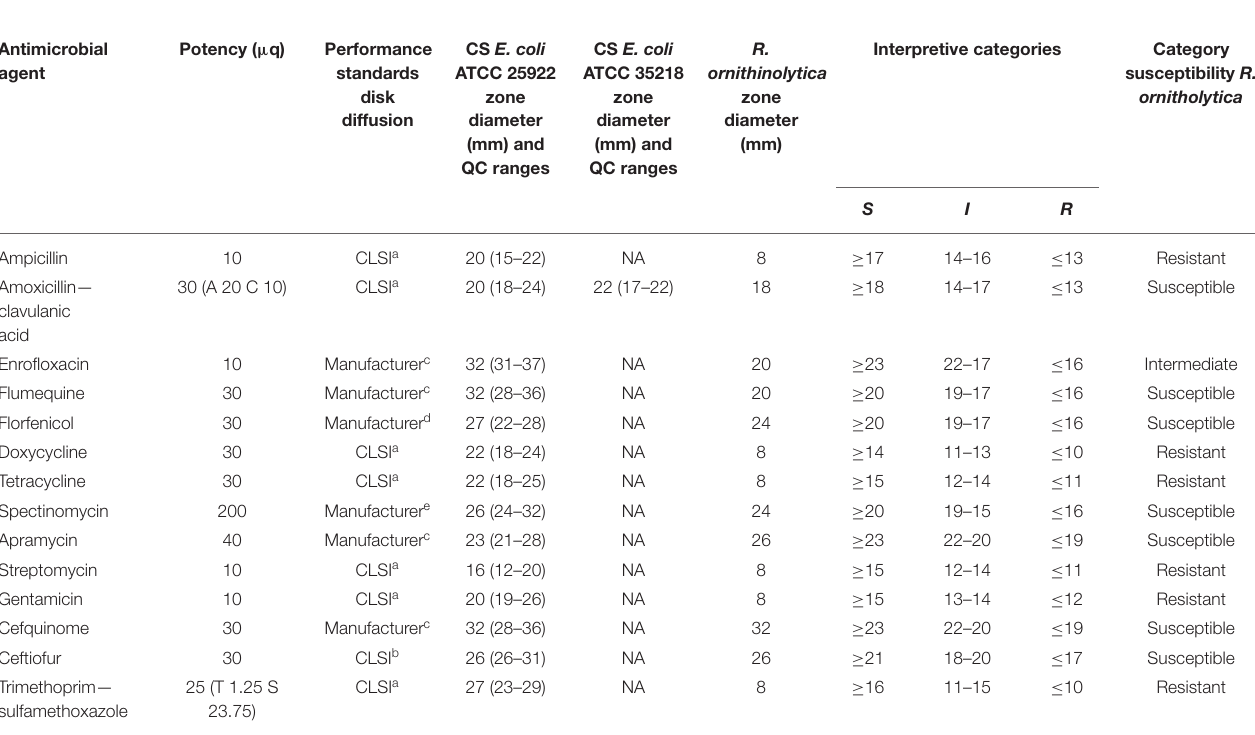
TABLE A1 | Disk diffusion susceptibility for Raoultella ornithinolytica per antimicrobial agent, including information about potency disks, diameter control strains ( E. coli ATCC 25922 and E. coli ATCC 35218) and associated quality control values, zone diameter R. ornithinolytica and values for interpreting a susceptibility category.